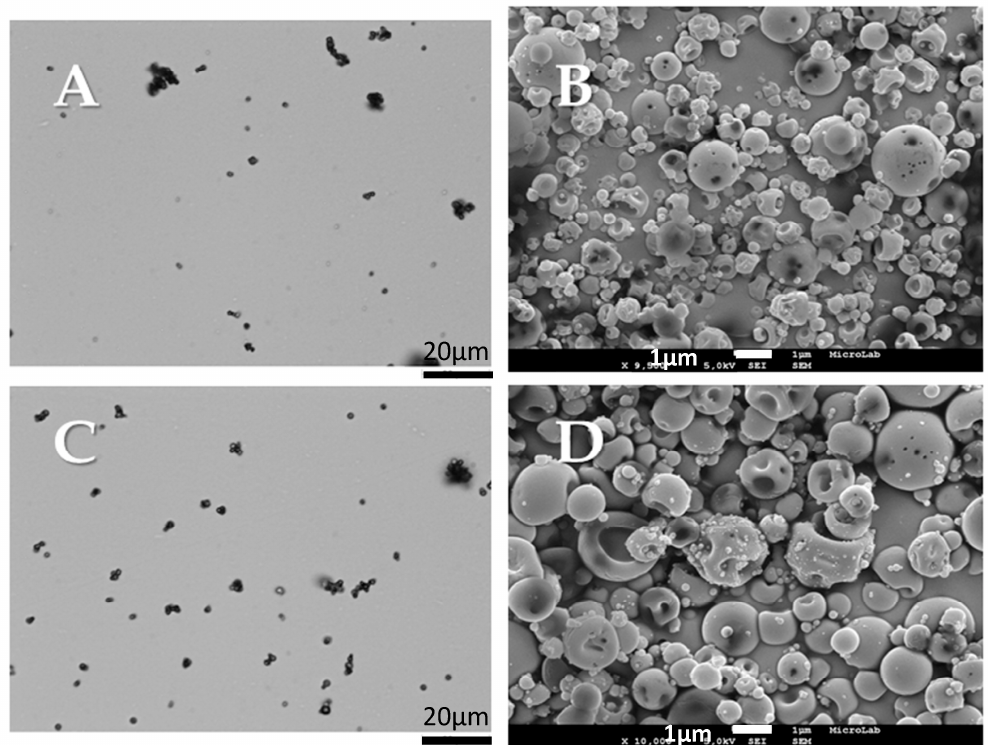
Figure 5. Morphological analysis of the produced particles: CHT: ( A ) Morphologi G3 image; ( B ) SEM image; CHT_Fe@Au_POX-SH: ( C ) Morphologi G3 image; ( D ) SEM image.